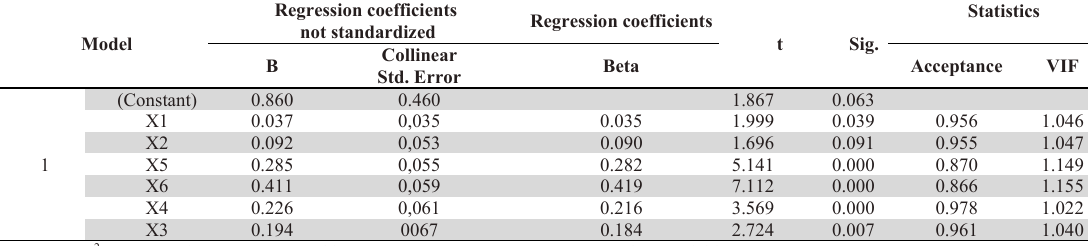
Parameters in the regression